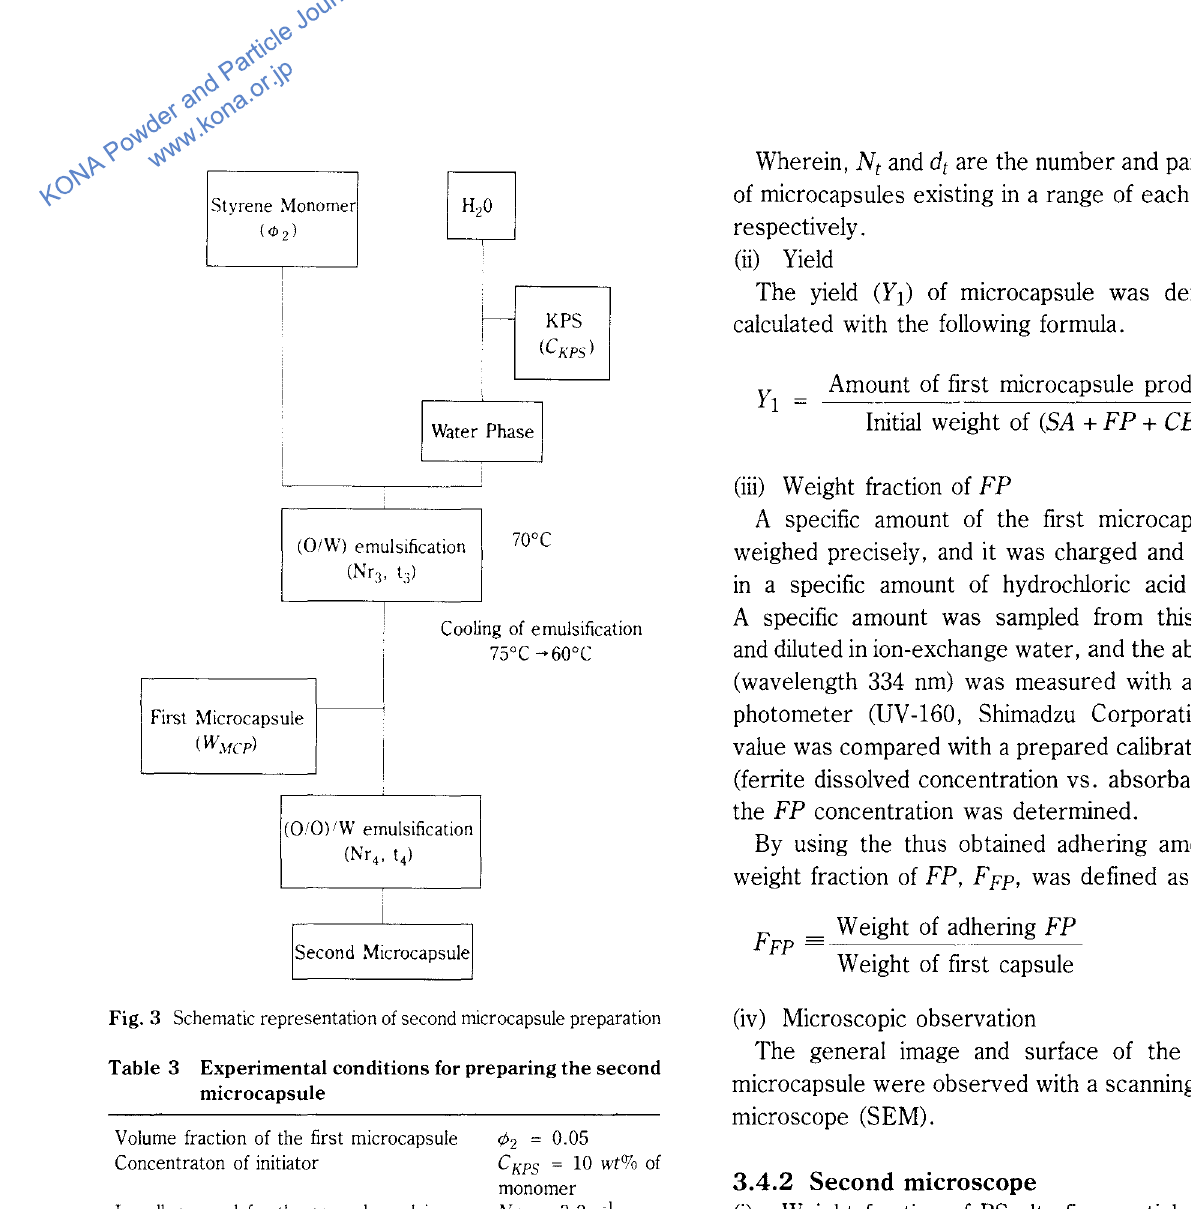
Fig. 3 Schematic representation of second microcapsule preparation Table 3 Experimental conditions for preparing the second microcapsule